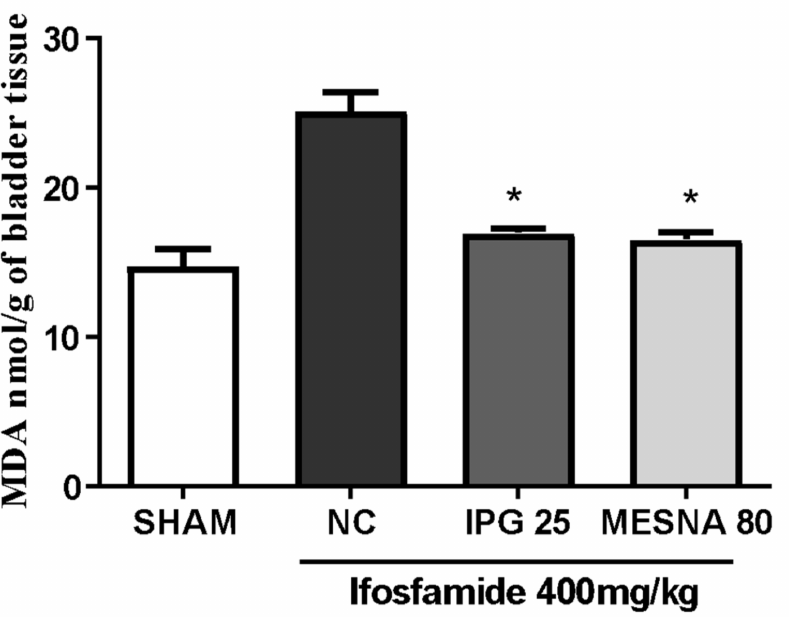
Figure 8. Effect of IPG on bladder MDA levels in animals with ifosfamide-induced hemorrhagic cystitis. Data are expressed in nmol of MDA per g of tissue, as mean ± SEM ( n = 6). Data were compared with the negative control (Tween/saline) by one-way analysis of variance (ANOVA), followed by the Bonferroni test; * p < 0.05.